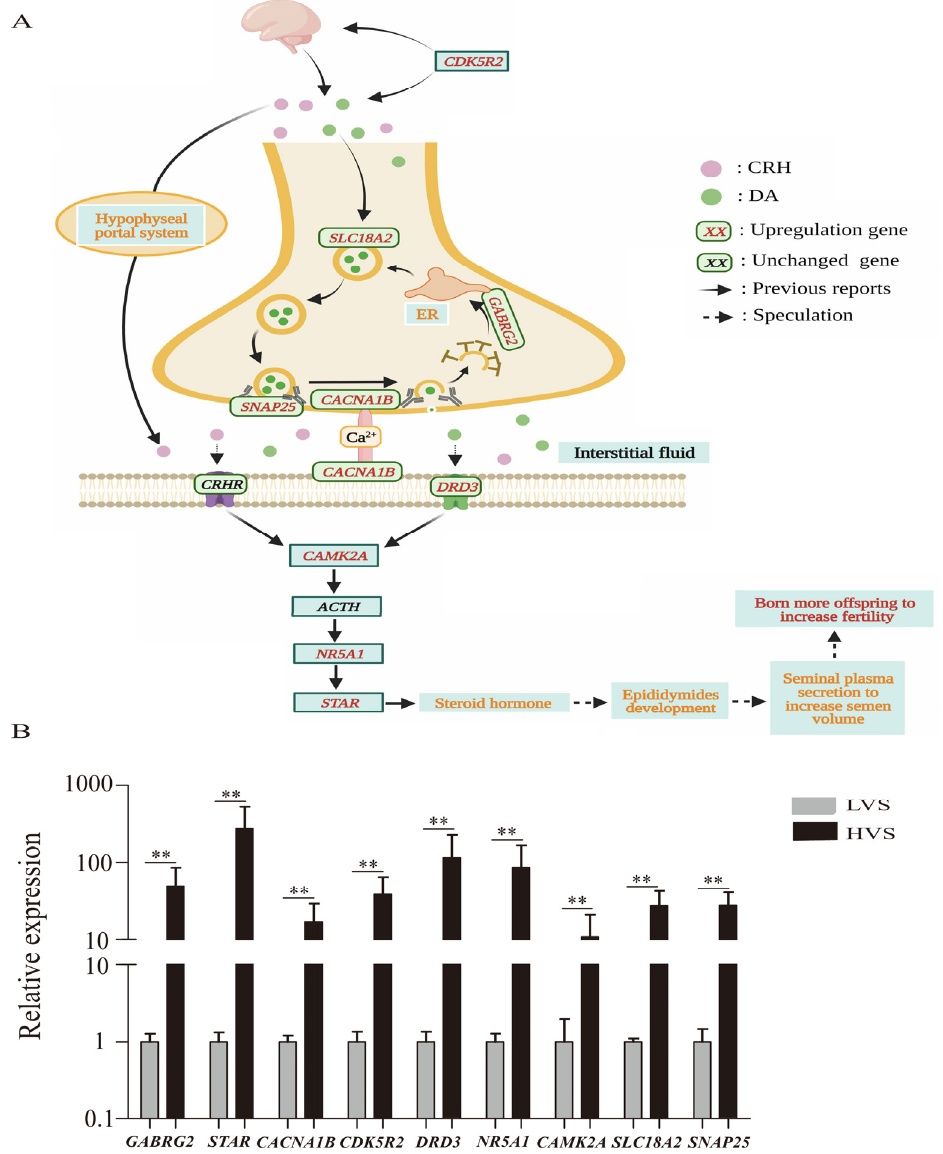
Figure 4. ( A ) Regulation network involved in semen volume of drakes and ( B ) the expression levels of STAR , CACNA1B , CDK5R2 , DRD3 , NR5A1 , CAMK2A , SLC18A2 , SANP25 , and GABRG2 that were detected from epididymis of drakes with different semen volume by RT ‐ qPCR. “DA” means dopamine; “CRH” means corticotrophin ‐ releasing hormone; “ER” means endoplasmic reticulum; “HVS” means high ‐ volume semen; “LVS” means low ‐ volume semen; “**” means p < 0.01.